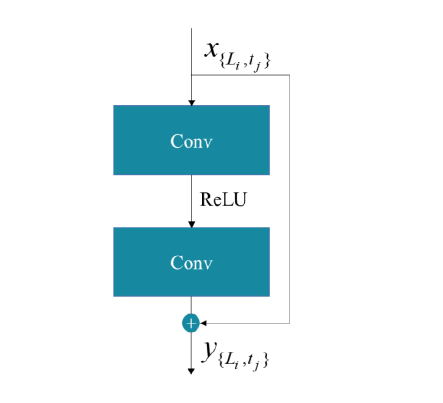
Fig. 2 Residual Block.